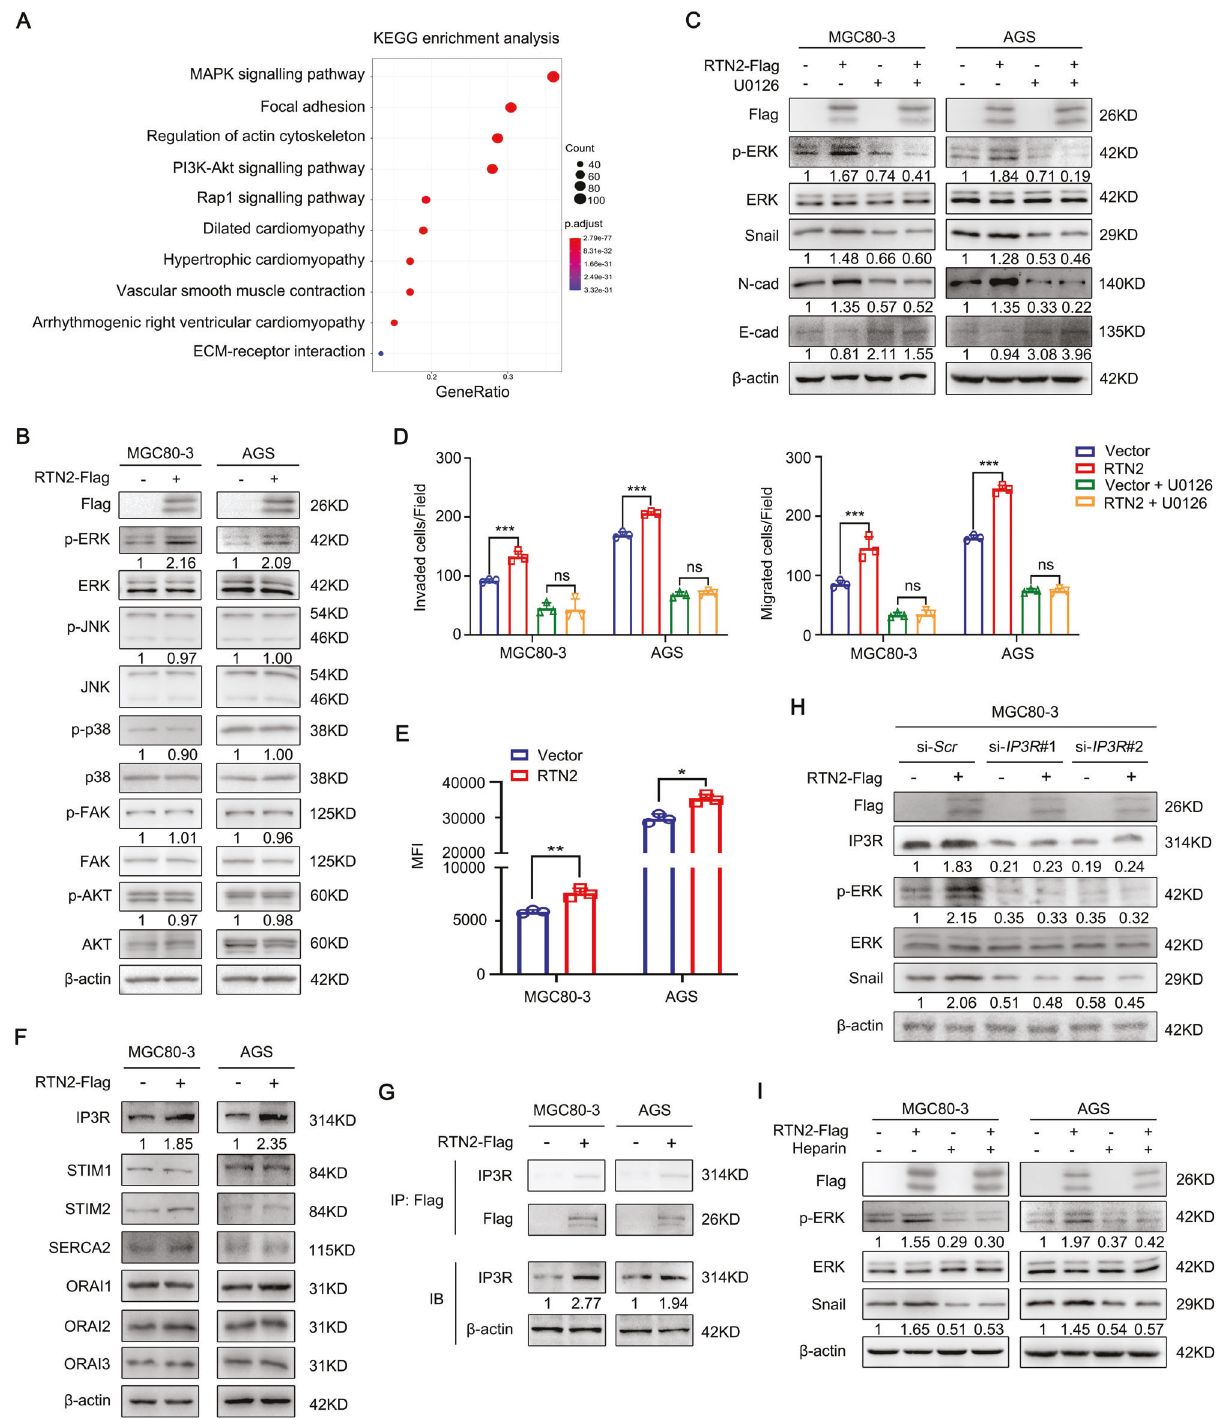
Fig. 6 RTN2 promotes EMT, migration and invasion of gastric cancer cells through ER Ca 2 + ef fl ux-mediated ERK activation. A KEGG pathway enrichment analysis of RTN2-associated signalling pathways. B Western blot validation of predicted pathways. C The effects of U0126 (10 μ M) on RTN2-associated ERK phosphorylation and EMT markers. D Transwell assays were performed to determine the invasion (left panel) and migration (right panel) capacities of MGC80-3 and AGS cells. E Cytoplasmic Ca 2 + was evaluated by FACS after staining with Fluo-3 AM in RTN2-overexpressed or controlled gastric cancer cells. F The effects of RTN2 on Ca 2 + -related channels including IP3R, SERCA2, STIM and ORAI were examined by western blot. G MGC80-3 and AGS cells were transfected with RTN2 or empty vector, and applied to immunoprecipitation assay. H Gastric cancer cells were transfected as indicated and applied to western blot. I MGC80-3 and AGS were transfected with RTN2 or empty vector, treated with or without heparin (5 mg/mL), and then applied to western blot. D , E Results are presented as mean ± SD. Statistical signi fi cance was calculated by Student ’ s two-tailed t test. * P < 0.05; ** P < 0.01; *** P < 0.001; ns no signi fi cance.